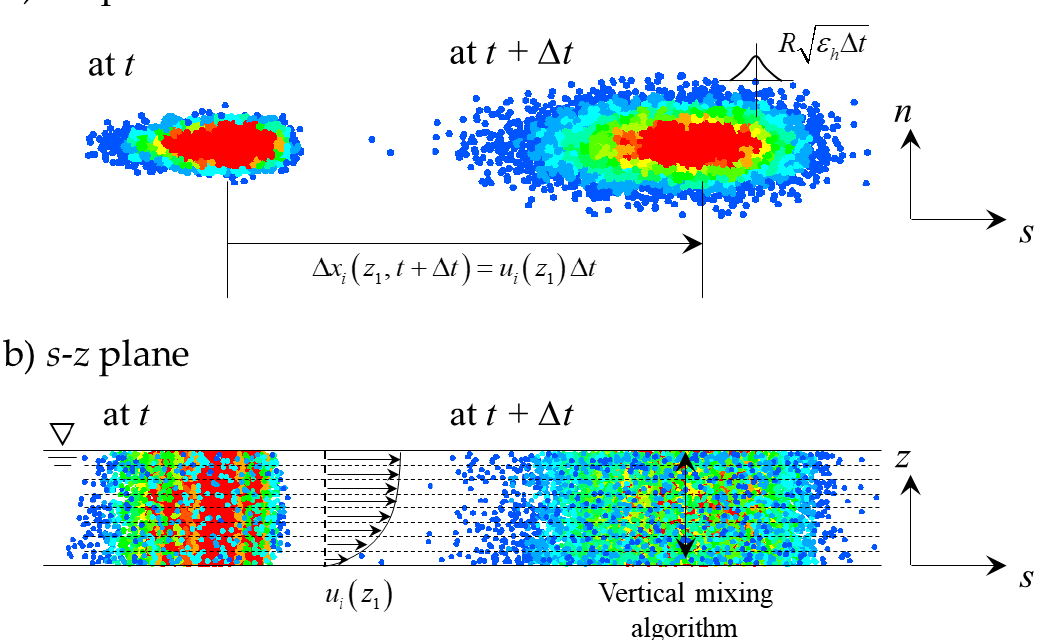
Figure 3. Descriptions of the two-dimensional particle mixing procedures using the particle dispersion model (PDM).